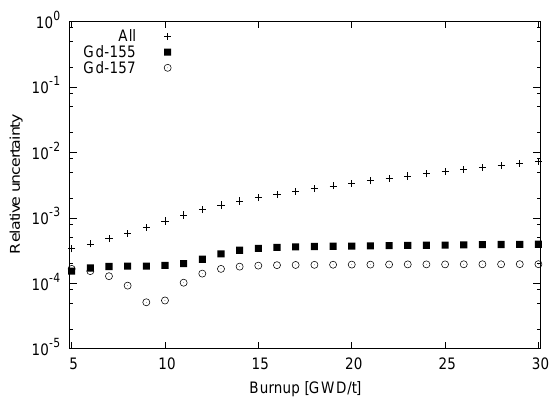
Figure 7. Nuclear data-induced uncertainty in U-235 number density during burnup